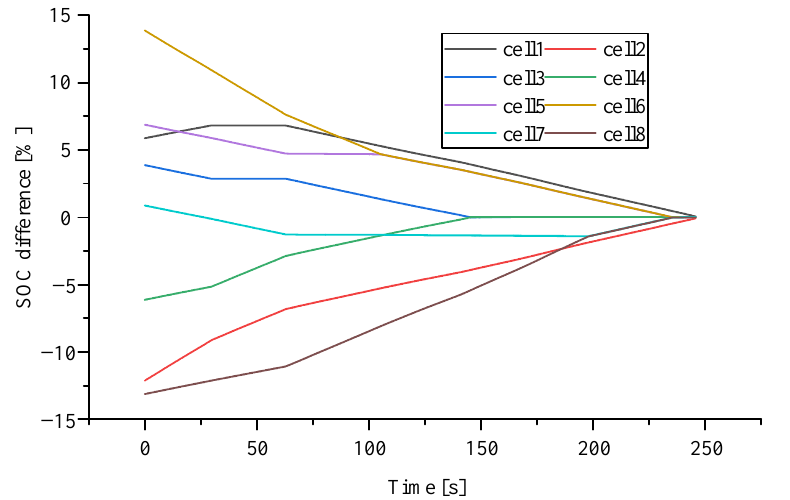
Figure 6. Lithium battery SOC difference diagram. (Multi-layer equalisation circuit without equalisa- tion strategy).